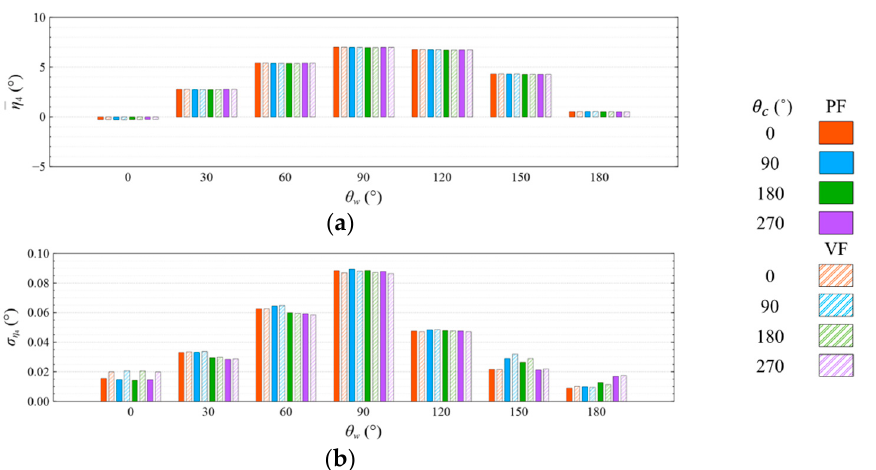
Figure 17. Comparison of ( a ) means and ( b ) standard deviations of platform roll motion under CW condition.